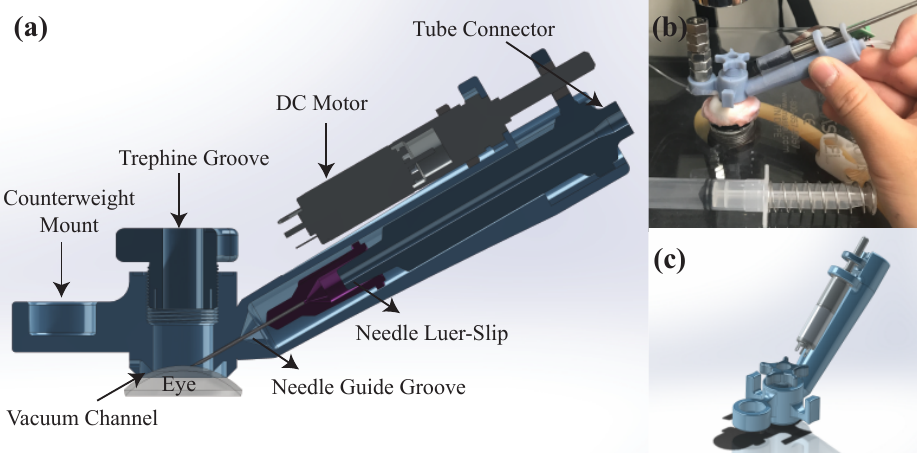
Figure 3. ( a ) Cross-section CAD view of the AUTO-DALK device. ( b ) Experimental setup using the AUTO-DALK device on porcine eye. ( c ) CAD isometric view of the AUTO-DALK